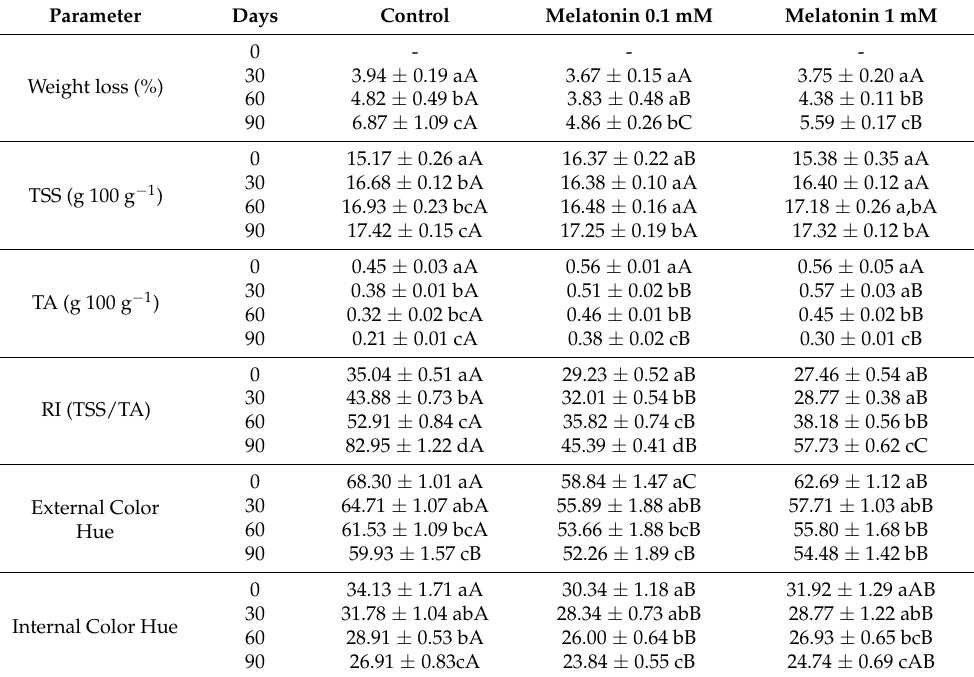
Table 3. Physiological and biochemical parameters in pomegranate fruits from control and melatonin- treated trees (0.1 and 1 mM) at harvest (day 0) and during 90 days of storage at 10 ◦ C. Year